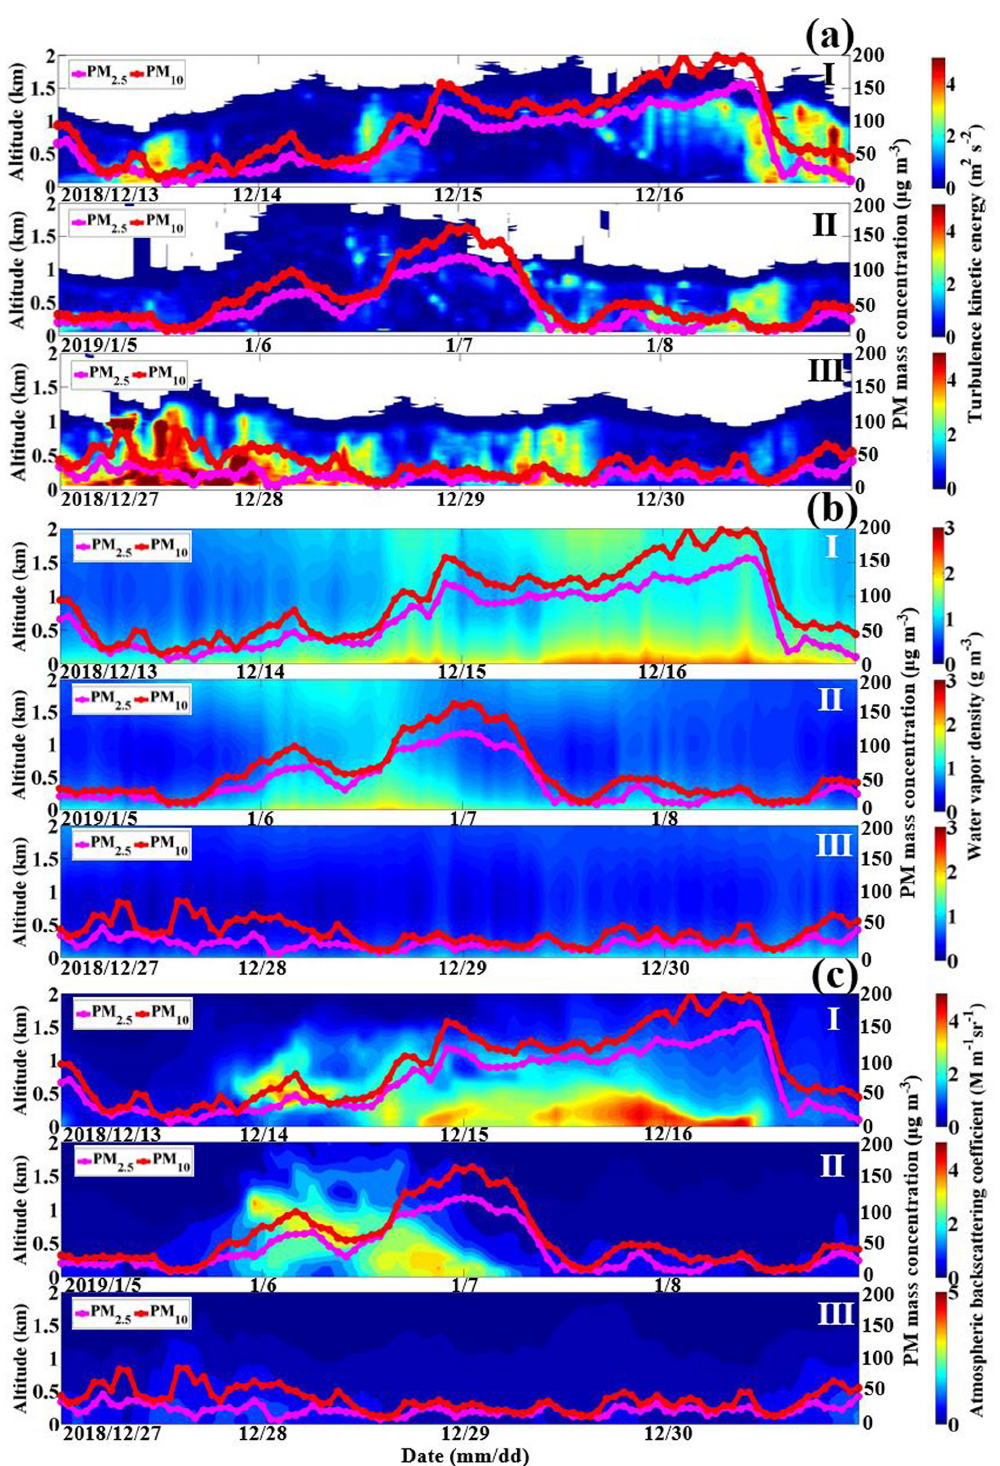
Figure 3. Temporal variation in the vertical profiles of (a) the turbulent activity (shaded colors: TKE), (b) atmospheric humidity (shaded colors: vapor density) and (c) vertical distribution of suspended particles (shaded colors: BSC) during the typical haze pollution episodes of I (13–16 December 2018) and II (5–8 January 2019) as well as the typical clean period of III (27–30 December